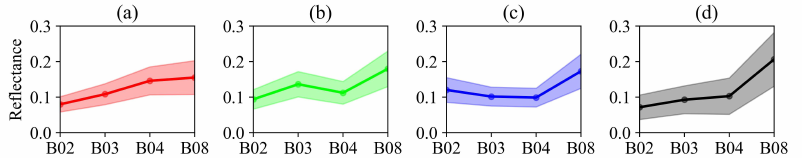
Figure 3. Mean VIS-NIR spectra by class (standard deviation in shaded area): ( a ) red. ( b ) green. ( c ) blue. ( d )